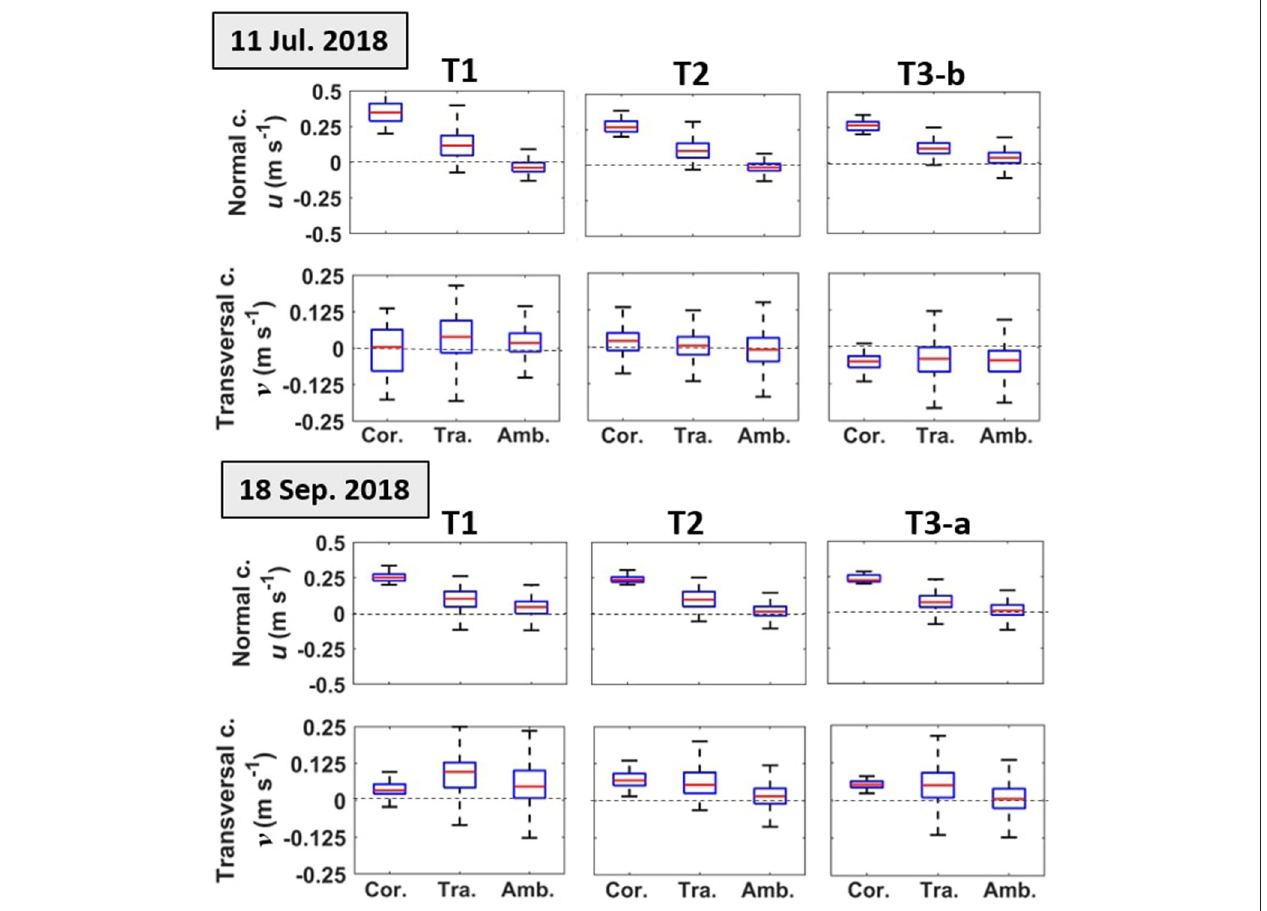
FIGURE 6 | Box plots of the normal ( u ) and transversal ( v ) current components in transects T1, T2, and T3-b for 11 July 2018 (top panels) and in transects T1, T2, and T3-a for 18 September 2018 (bottom panels) for the three zones: core zone of the interflow (Cor.), transition zone between the interflow and the ambient waters (Tra.), and ambient water zone (Amb.). The red line in each box indicates the median, and the bottom and top edges of the box, the 25th and 75th percentiles. The whiskers extend to the most extreme data points. For location of transects, (see Figure 1B